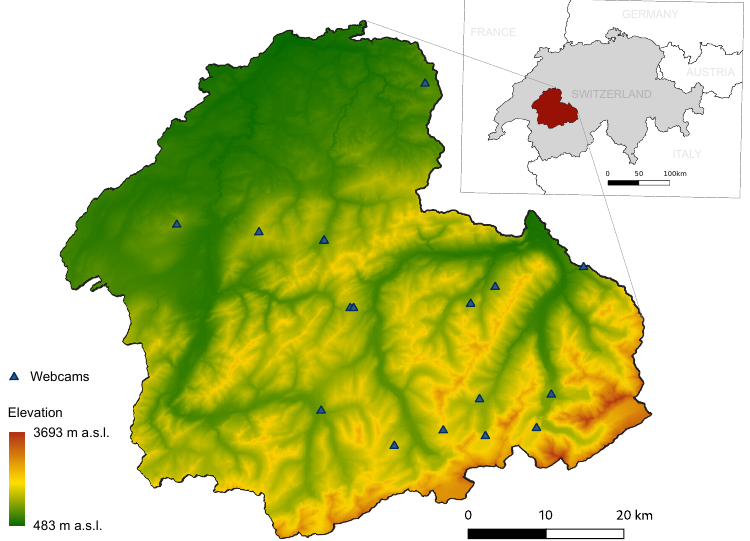
Figure 2. Study area and webcam locations. Background data: swissALTI 3D and swissBoundaries © swisstopo.